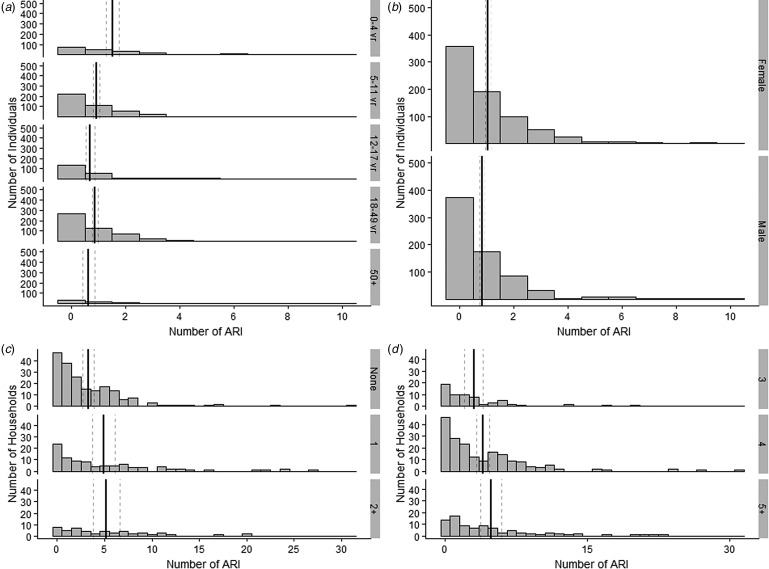
Distribution of ARI by individual and household characteristics. Solid vertical lines represent group mean, dashed lines represent 95% CI around the mean ARI: (a) distribution of individuals by number of ARI reported, stratified by age category; (b) distribution of individuals by number of ARI reported, stratified by gender; (c) distribution of households by number of ARI reported, stratified by number of children <5 years living in the household; (d) distribution of households by number of ARI reported, stratified by total household size.